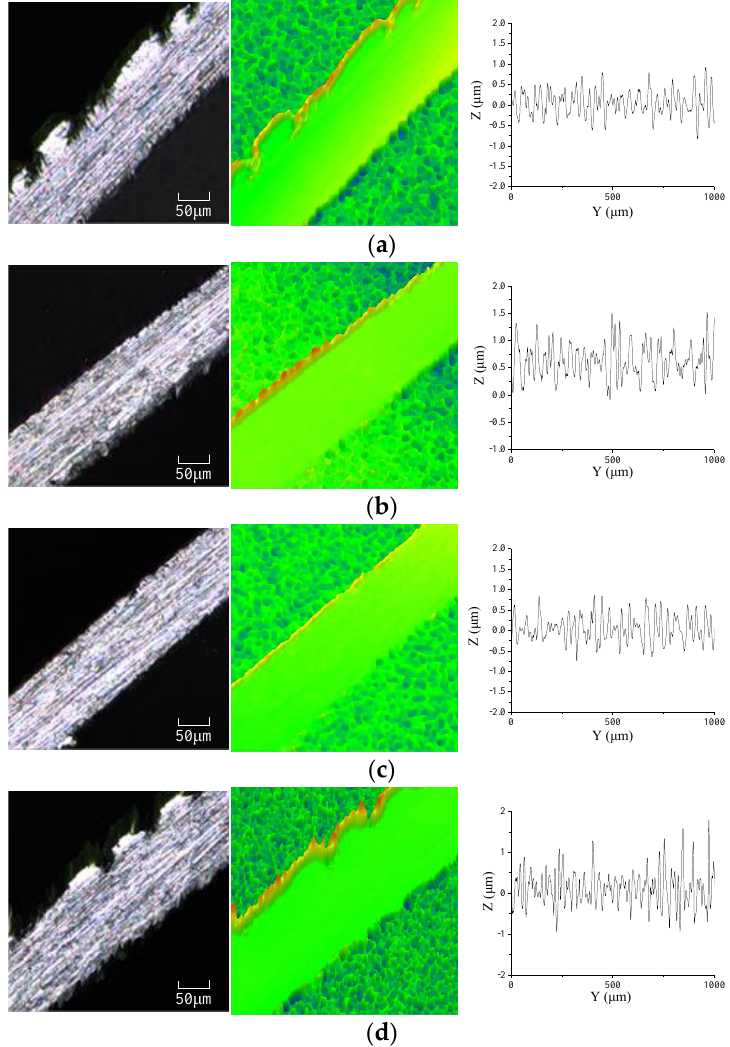
Figure 9. 3D views and profiles of the side wall of slits under different initial and secondary velocities: ( a ) 50 and 50 μm·s −1 ; ( b ) 50 and 500 μm·s −1 : ( c ) 25 and 50 μm·s −1 ; ( d ) 10 and 50 μm·s −1 .